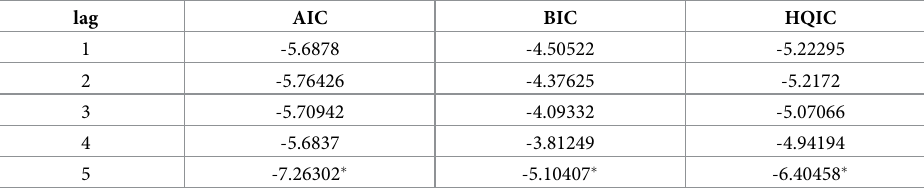
Table 21. Lag test of PVAR model for logistics and the efficiency of the two-industry-linkage.